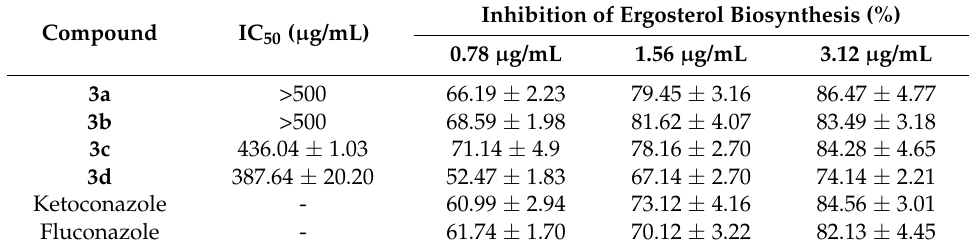
Table 2. Cytotoxic activity and ergosterol biosynthesis inhibition potency of Compounds 3a – 3d against NIH/3T3 cell line and C. krusei ,